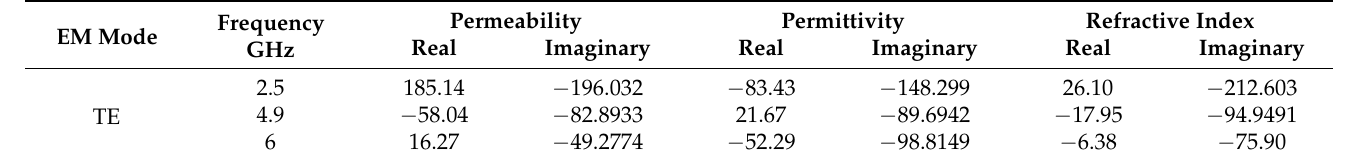
Table 4. Metamaterial property (real and imaginary values) at the resonant frequency.